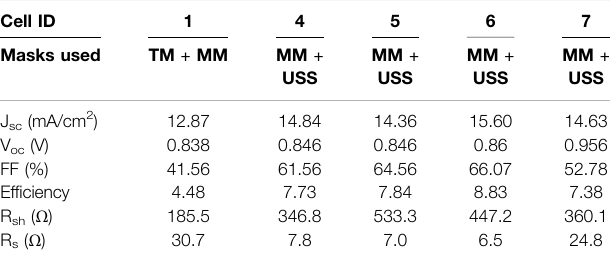
TABLE 2 | Electrical parameters of the fabricated p-i-n solar cells using the different combinations of masks (TM: Kapton tape mask, MM: metal mask, and USS: ultrasonic